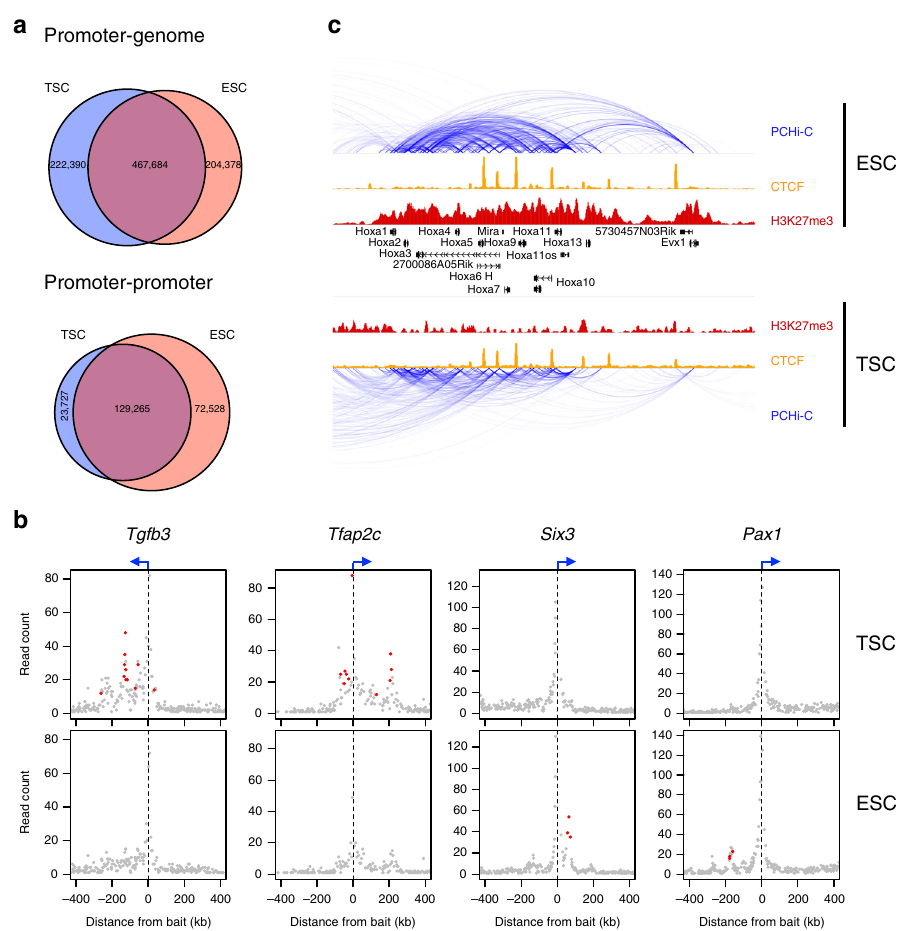
Fig. 1 Differential interactions between TSCs and ESCs. a Venn diagrams comparing the signi fi cant interactions from TSC and ESC PCHi-C data, separated into interactions with non-promoter regions (promoter – genome) or with other promoters (promoter – promoter). b Examples of differential interactions between TSCs and ESCs. Read counts of fragments interacting with selected promoters are displayed, with differential interactions highlighted in red. c Genome browser view of the Hoxa gene cluster highlighting a reduction in intra-cluster interactions in TSC